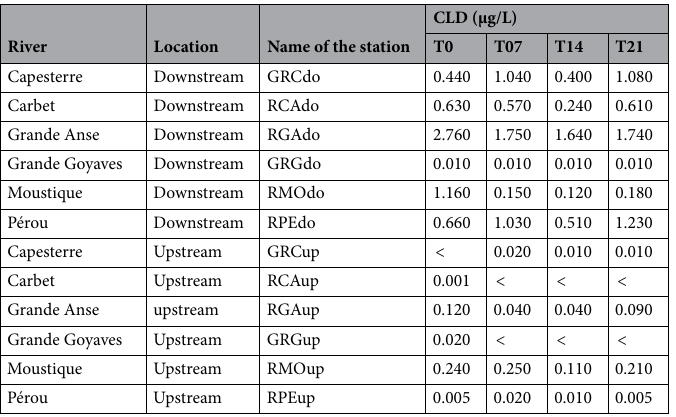
Table 1. Chlordecone (CLD) concentrations in the water at each station are based on four samples taken in February 2013. Downstream and upstream refer to the location of the sampling stations in relation to the banana plantations. T0 = slide immersion, T07, T14, T21 = + 7, + 14, and + 21 days. <, less than the analytical